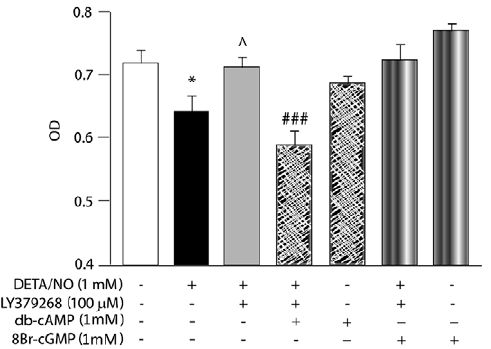
Figure 5. Cytoprotective action of mGluR3 agonists is mediat- ed by reduction of cAMP levels but not by cGMP. Astrocyte primary cultures were incubated with 1 mM DETA/NO in the presence or absence of 100 m M LY379268 and/or 1 mM db-cAMP or 1 mM 8Br- cGMP for 48 h. Cell viability was assayed by the MTT method. Bars represent the mean 6 SEM of 6–8 determinations per group, of one representative experiment of 2 independent ones. *p , 0.05 versus control; ‘ p , 0.05 versus DETA/NO; ### p , 0.001 versus DETA/ NO + LY379268.